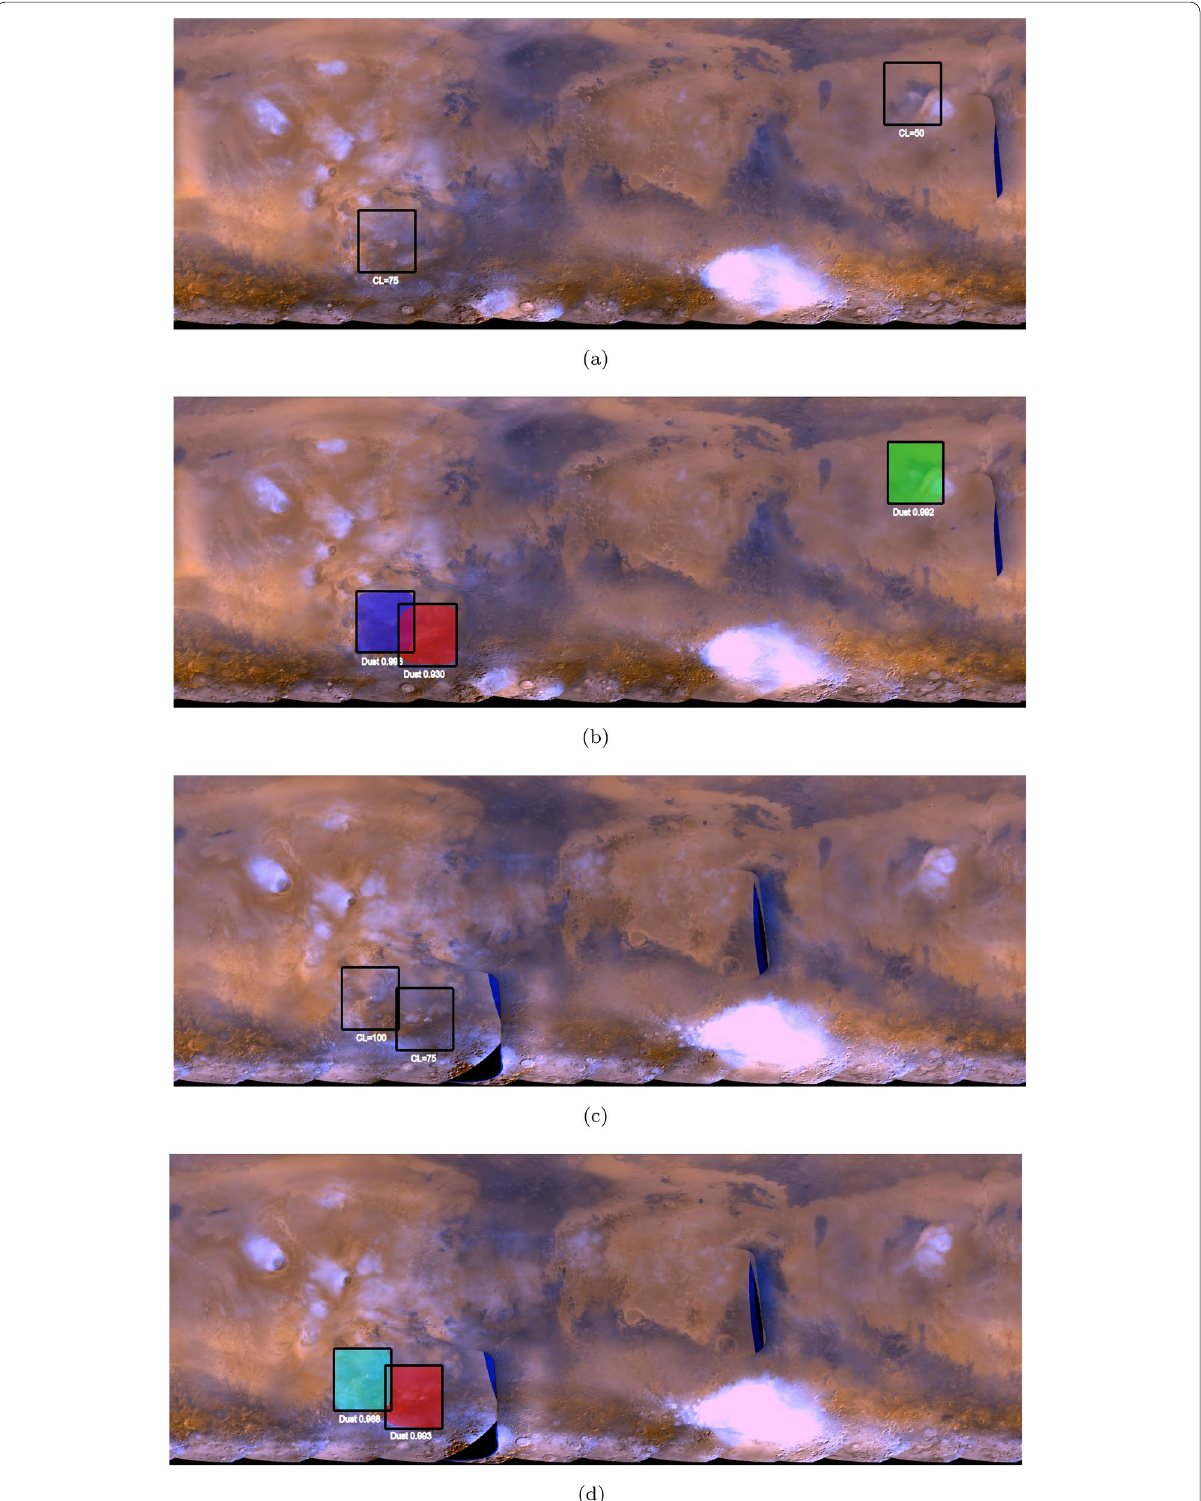
Fig. 3 1st strategy: the training and validation images are selected randomly from MY 25 to middle of MY 27. The testing images are selected randomly from middle of MY 27 to MY 28. a and c are ground-truth images from spring ( s 20_23 ) and summer ( s 22_22 ) seasons at L S = 83.04 ◦ and L S = 110.25 ◦ , respectively. b and d are their predicted dust